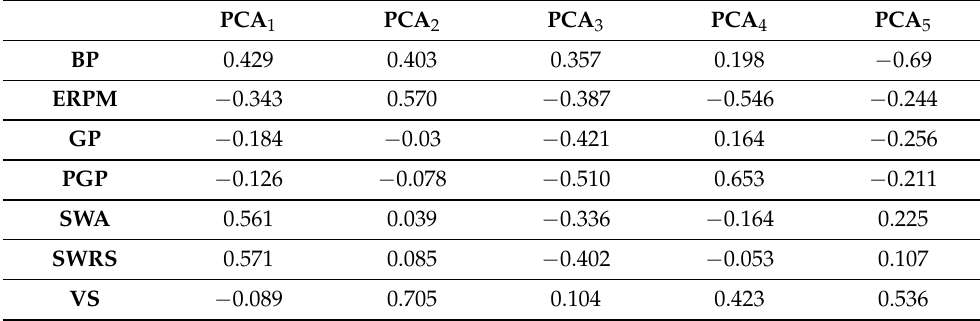
Table 2. Coefficients of the PCA model trained with driver-controlled variables.